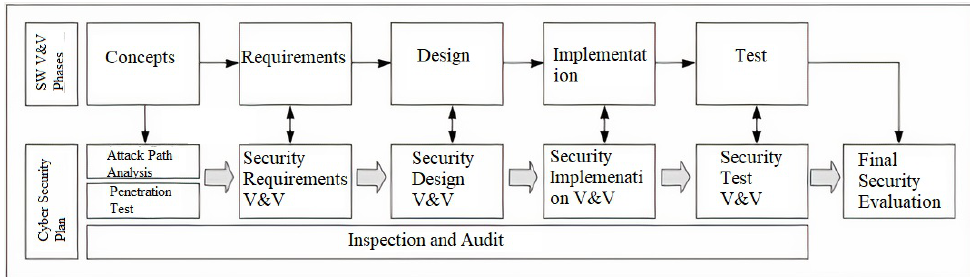
Figure 1. CS plan and activities for NPP protection, from “Implementation of cyber security for safety systems of nuclear facilities” by Park, J.; Suh, Y.; Park, C., 2016, Prog. Nucl. Energy, 88, 88–94. Copyright 2021 by Elsevier